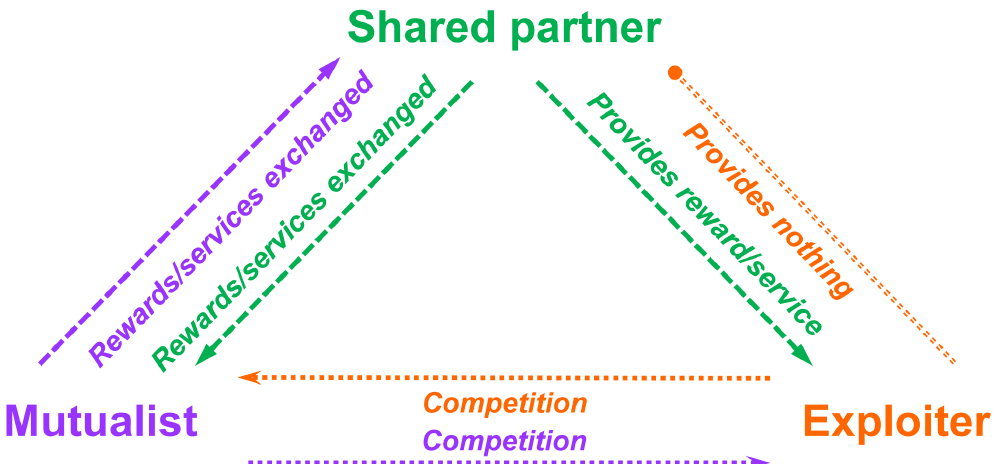
Fig 1. The three parties in the interactions we consider. The exploiter provides no reward or service in exchange for the commodity it takes from the shared partner and competes with the mutualist to obtain this commodity. We focus on cases where the mutualist and exploiter are different individuals exhibiting pure behavioral strategies, rather than a single individual that switches roles (a mixed